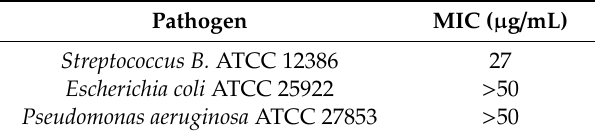
Minimum inhibitory concentration (MIC) of accramycin A 1 against a panel of bacterial